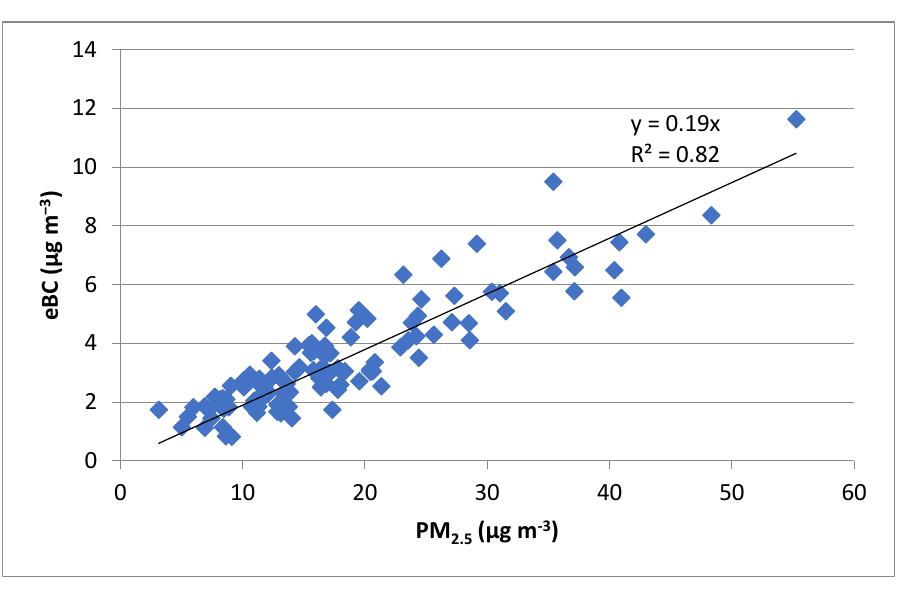
Figure 9. Regression of concentration eBC versus PM 2.5 for the full period.